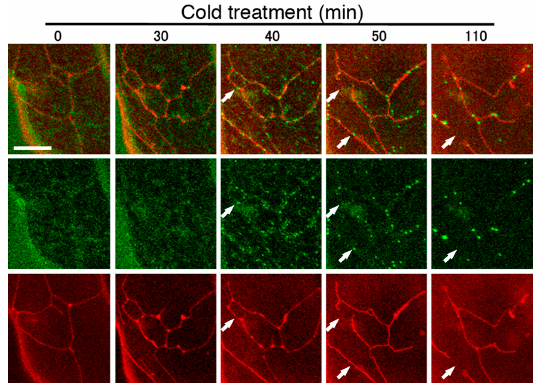
Figure 7. Time course observations of mitochondria and DRP3A in the elm1 mutant. Images show a double-stained leaf epidermal cell of a 30-day-old elm1-6 Arabidopsis plant transformed with DRP3Apro:DRP3A: GFP at different times after cold treatment. Bottom panels, mitochondrial network stained with MitoTracker; middle panels, DRP3AGFP; top panels, merged MitoTracker and GFP images. Cytosolic DRP3A: GFP first appeared as a hazy signal (0 and 30 min) and gradually localized and concentrated on mitochondria (40, 50 and 110 min). Arrows indicate sites of mitochondrial fission. Scale bar, 10 μ m, is applicable to the all images.